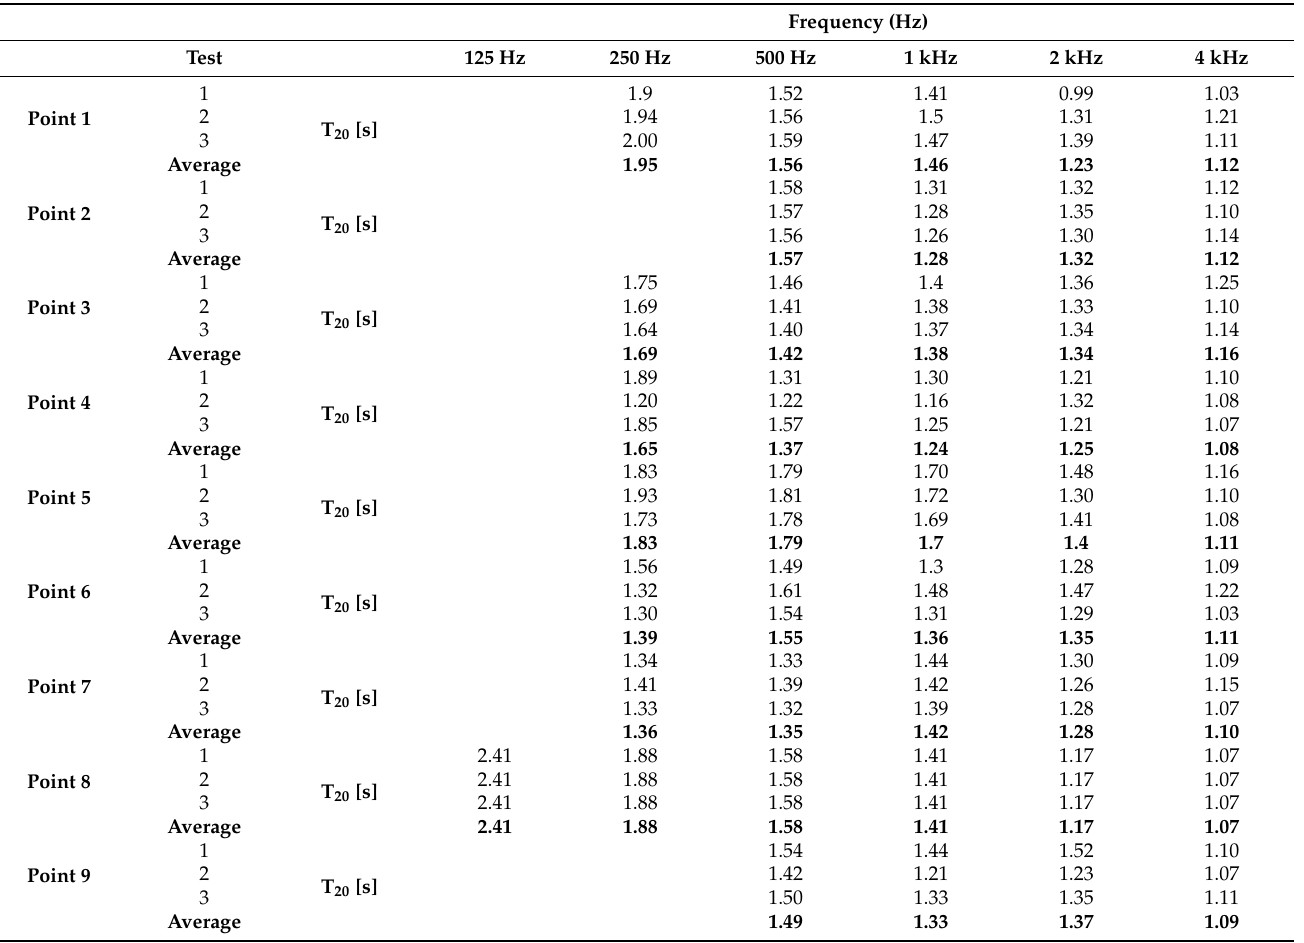
Table 12. On-site measurements: T 20 of Combo